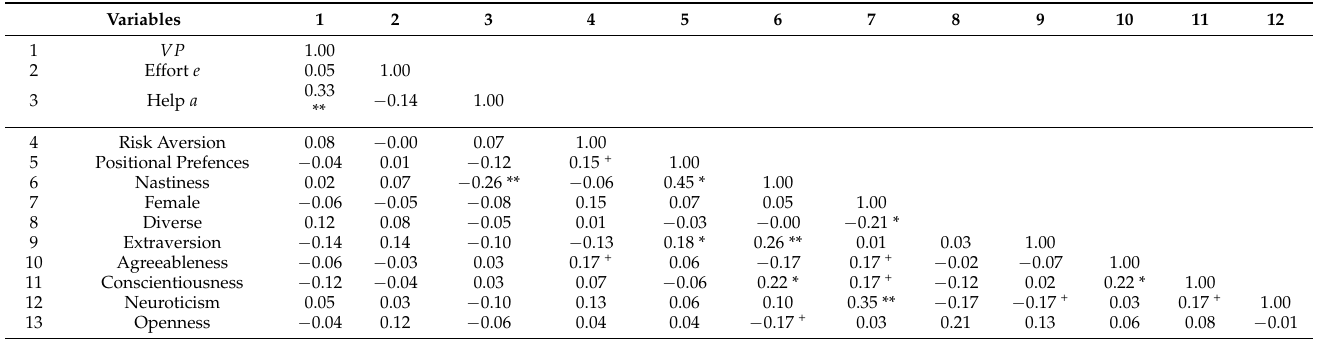
Table 2. Correlations.